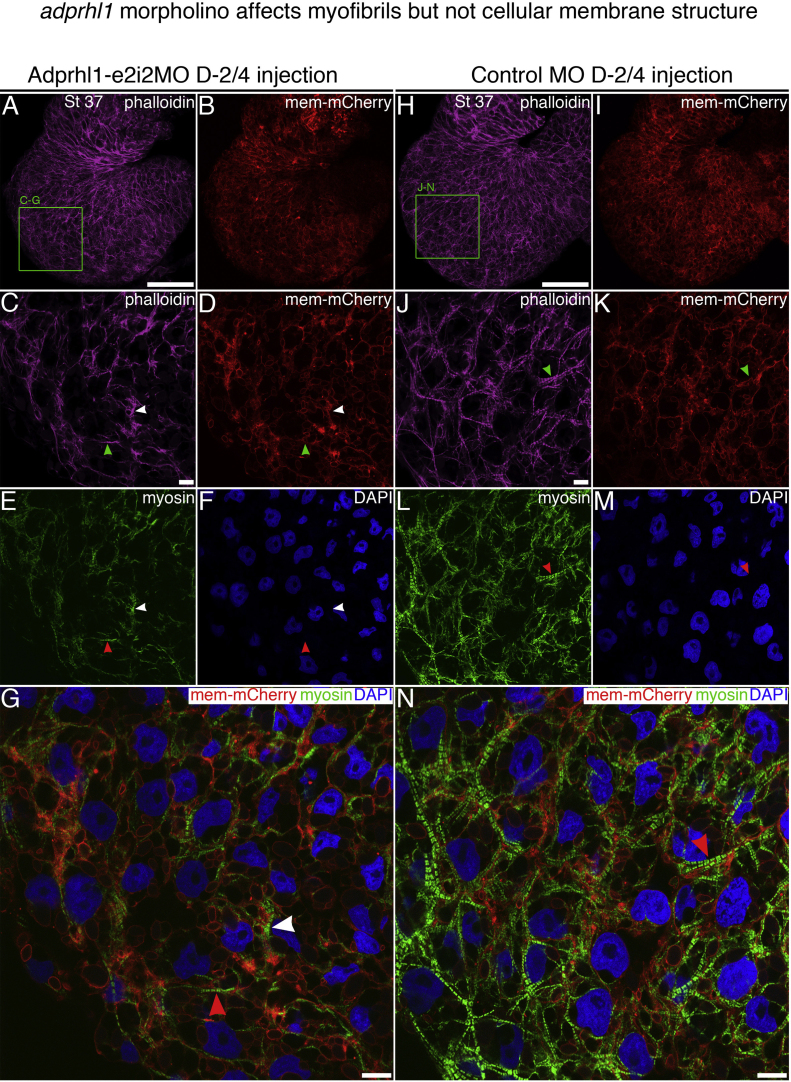
Adprhl1 morpholino affects myofibrils but not cellular membrane structure. A–G: A stage 37 heart, dissected after co-injection of Adprhl1-e2i2MO with membrane-tagged lyn-mCherry RNA into D-2/4 blastomeres. H–N: Heart after control morpholino and lyn-mCherry RNA injection into D-2/4 blastomeres. The anterior surface of the hearts (A, B, H, I) lies upwards and magnified 134 µm images (C–G, J–N) show myofibril and membrane patterns in the ventricle wall. Phalloidin actin (magenta-A, C, H, J), membrane-tagged mCherry (red-B, D, I, K), anti-myosin heavy chain (green-E, L), DAPI (F, M) stains, plus RGB-channel merge (G, N). Panels show reduced myofibril content (arrowheads) in the forming ventricle upon adprhl1 knockdown but no clear change in cellular membrane shape or vesicle structure. Scale bars=100 µm (A, H). Scale bars=10 µm (C–G, J–N). White arrowheads, short, splayed myofibrils in morphant.